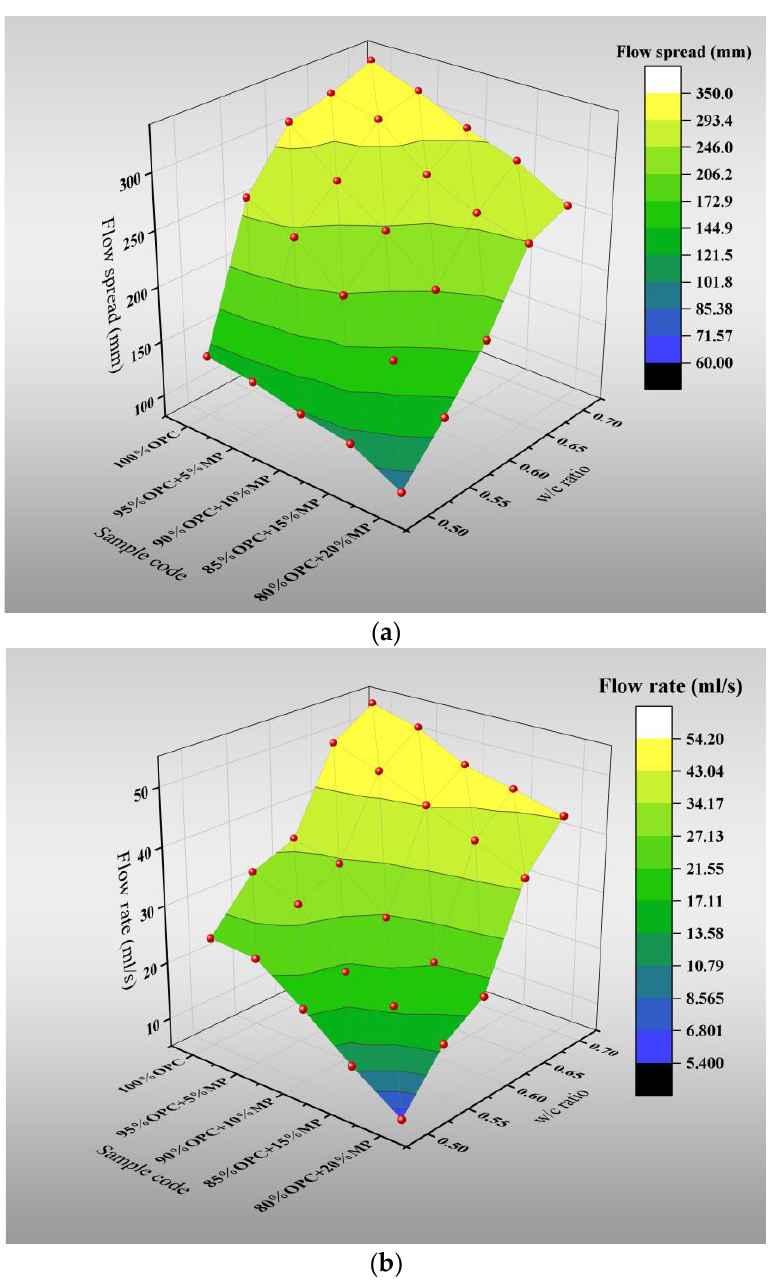
Figure 3. Differentiation of flow rate and flow spread with W/CM at various MP contents. ( a ) Flow spread. ( b ) Flow